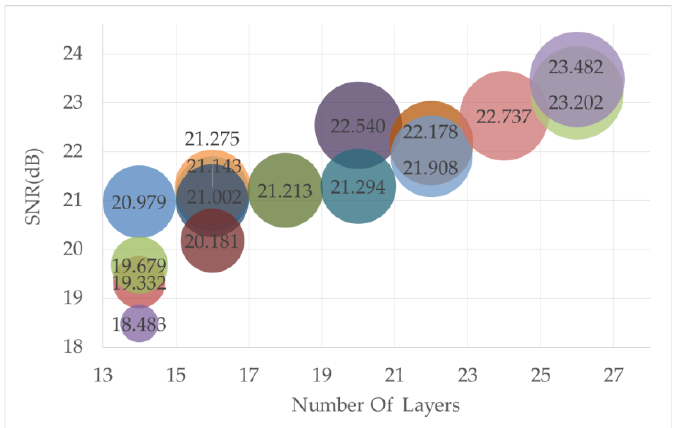
Figure 3. Denoising results of seismic data with SNR of 4.074 dB for DWT−Resnet18 networks with different numbers of layers for a fixed wavelet type and wavelet decomposition levels.